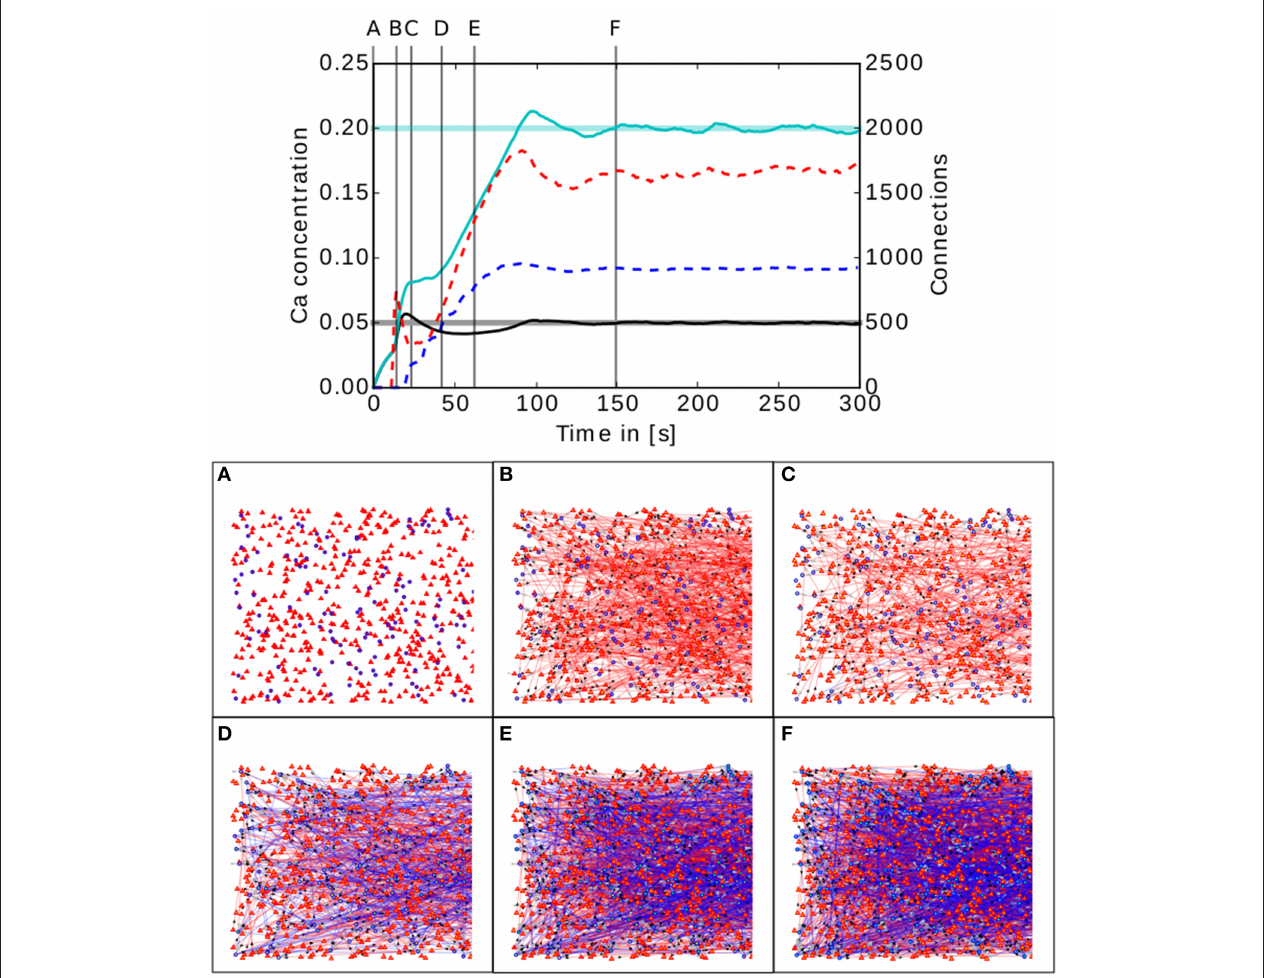
FIGURE 5 | Upper panel: Calcium concentration and numbers of connections as functions of time in a simple two population network. The cyan and black curves show the calcium concentration measured in the inhibitory and excitatory populations, respectively. The paler horizontal lines indicate the corresponding target levels ǫ . The blue and red dashed curves indicate the total number of connections in the inhibitory and excitatory populations, respectively. Vertical gray lines indicate the times of the snapshots displayed in the lower panel. Lower panel (A–F) : Evolution of the connectivity in the two population network visualized using MSPViz . Images show half of the total amount of neurons in the network, where triangles represent excitatory neurons and circles inhibitory neurons. Red lines indicate excitatory connections while blue lines indicate inhibitory connections.